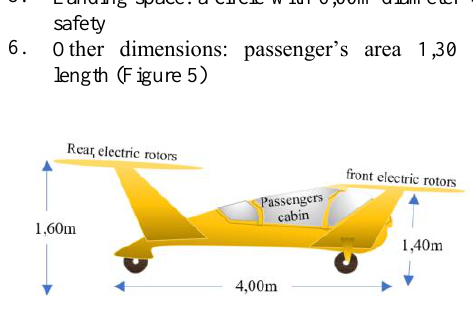
Figure 5 . Basic model side view and physical